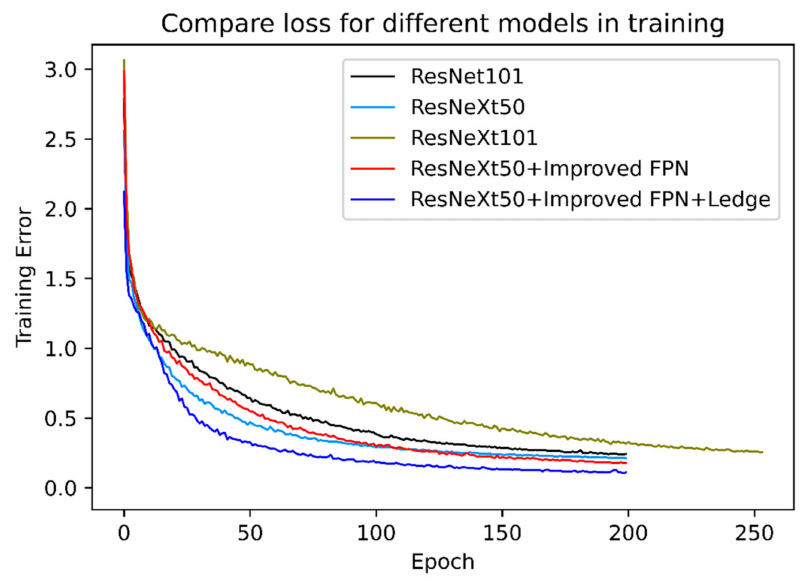
Figure 11. Training loss curve of five